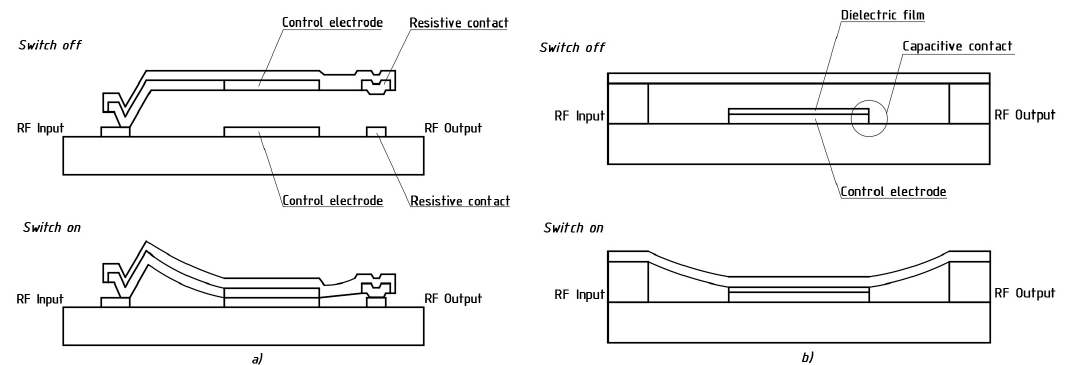
Figure 1. RF MEMS switches: ( a ) cantilever with resistive contact; ( b ) membrane with capacitive contact